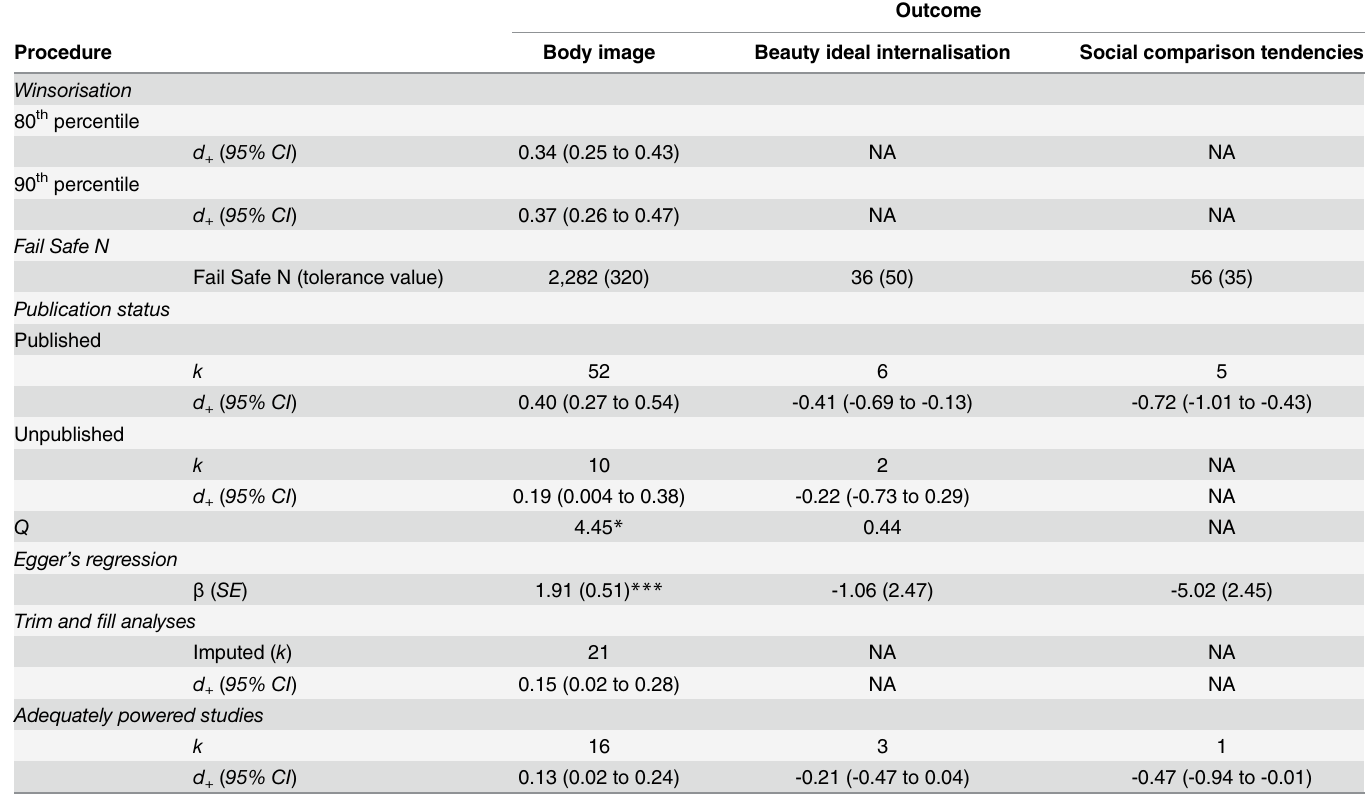
Table 4. Tests for Publication Bias and Small Sample